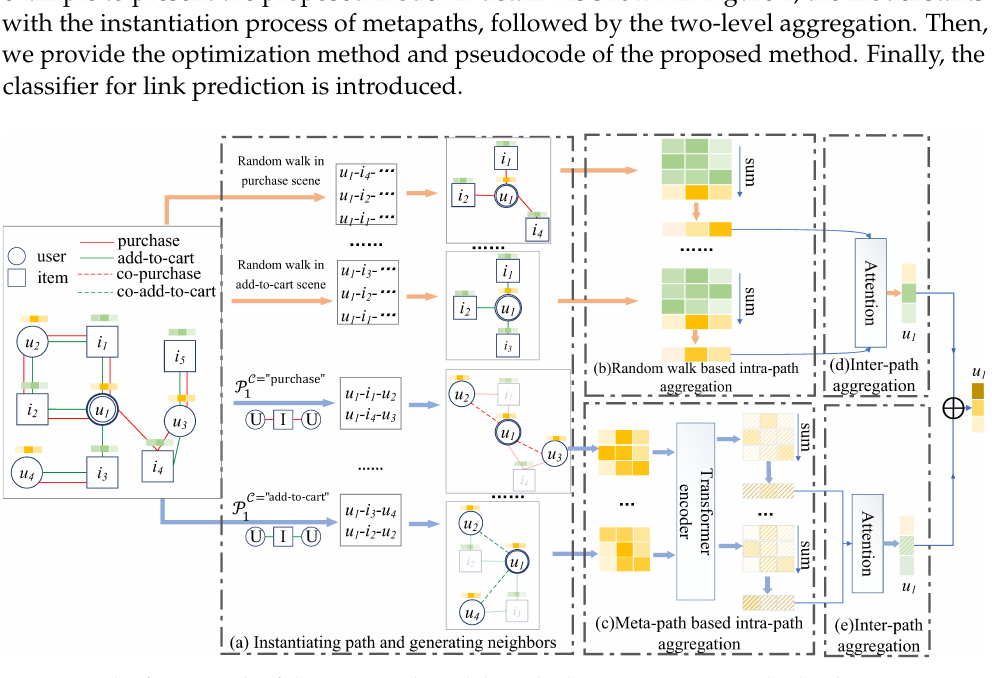
Figure 1. The framework of the proposed model. In the heterogeneous graph, the data processing is divided into two flow directions. Lastly, all the local embeddings are organically combined by two-level aggregation. (1) As shown by the orange arrow, in the relation subgraph, i.e., the edge type is constrained by purchase behavior. First, the sequences started from node u 1 are generated by the random walk method. Then, the most related neighbors of u 1 are obtained. Next, a particular embedding of u 1 can be gained by a sum over the embedding of the most related neighbors in the particular relation subgraph, i.e., the random walk-based intrapath view. Finally, the embeddings of u 1 in different relation subgraphs are obtained by random walk-based interpath aggregation. (2) As shown by the blue arrow, first, all the relation-constrained metapath instances started from node u 1 are generated. Then, the high-order neighbors of u 1 are obtained. Next, the initial embeddings of u 1 and its neighbors are fed to Transformer. Finally, another particular embedding of u 1 can be obtained by the sum over the output of the transformer. This flow is called metapath-guided intrapath aggregation. Furthermore, the results of metapath-guided interpath aggregation are assembled by each intrapath aggregation (best viewed in